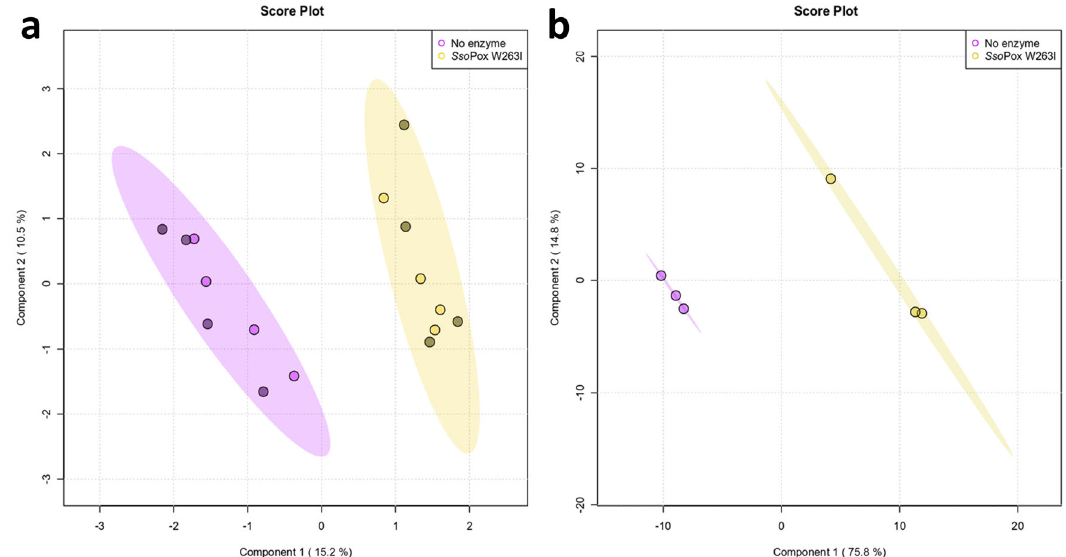
Fig. 1 PLS-DA analysis of proteomic and metabolomic data of C. violaceum cultures with and without lactonase treatment. Score plots of PLS-DA analysis of proteomic ( a ) ( n = 8: four biological replicates × two technical replicates indicated by darker point) and metabolomic data ( b ) ( n = 3: three biological replicates) of Sso Pox W263I (0.5 mg ml − 1 ) treated samples (yellow) and untreated ones as negative controls